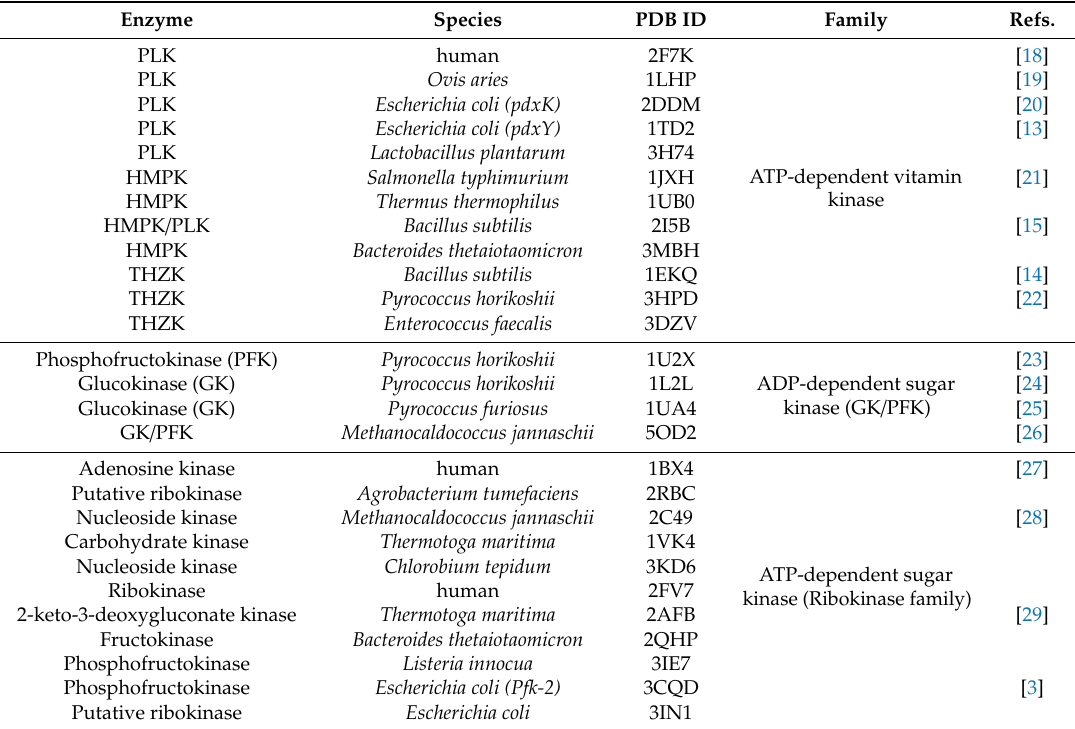
Table 1. Structures used for the structure-based sequence alignment of the ribokinase